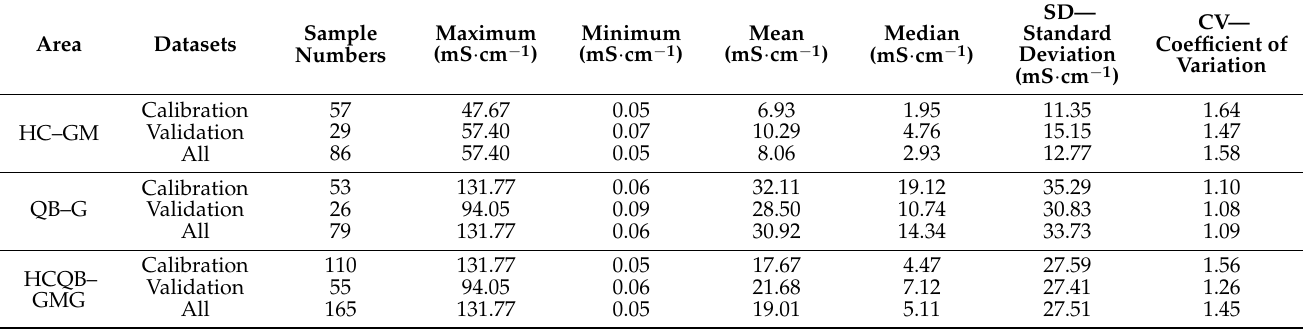
Table 5. Statistical characteristics of the EC of the soil samples from the different